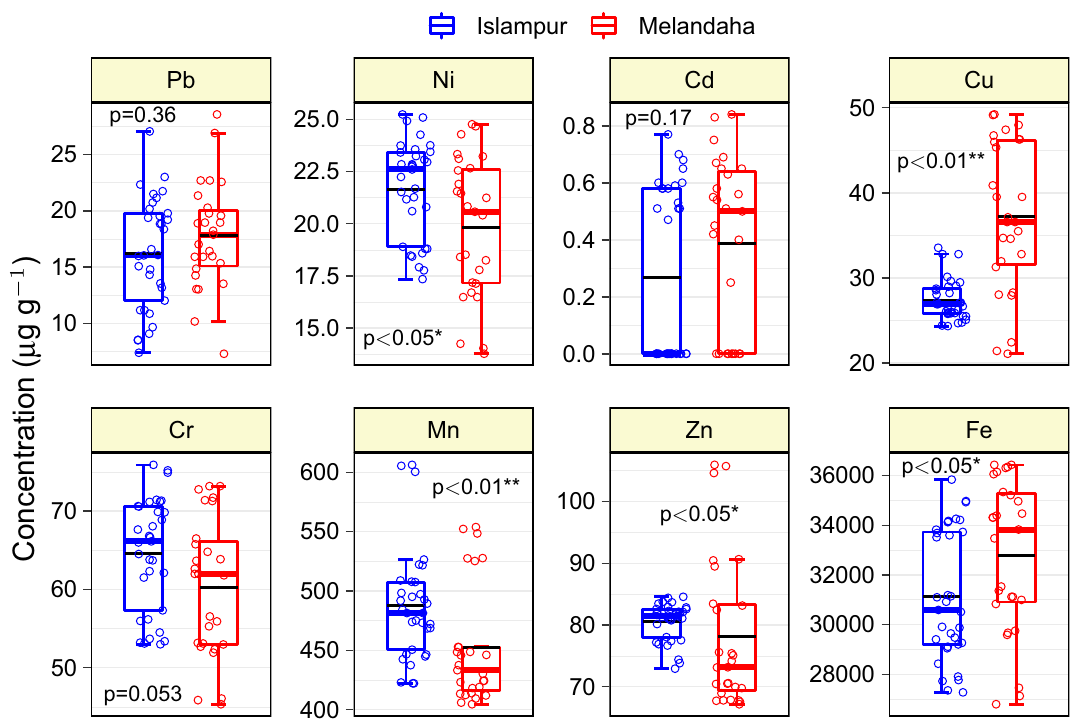
Figure 2. Trace elements concentration in different farmers ′ fields soils of brinjal producing areas of Islampur and Melandaha Upazila of Jamalpur district, Bangladesh. Lower and upper box boundaries are 25th and 75th percentiles, respectively, whereas the colored (blue or red) horizontal line inside the box is median and the black line represents the mean value. The lower and upper error lines are 10th and 90th percentiles, respectively. Data points falling outside 10th and 90th percentiles are the outliers. The p-values are mean comparison (nonparametric Kruskal–Wallis test) of soil metal concentrations sampled from two study locations. Single and double asterisks associated with the p-values designate the means are different at 5% and 1% level of probability,